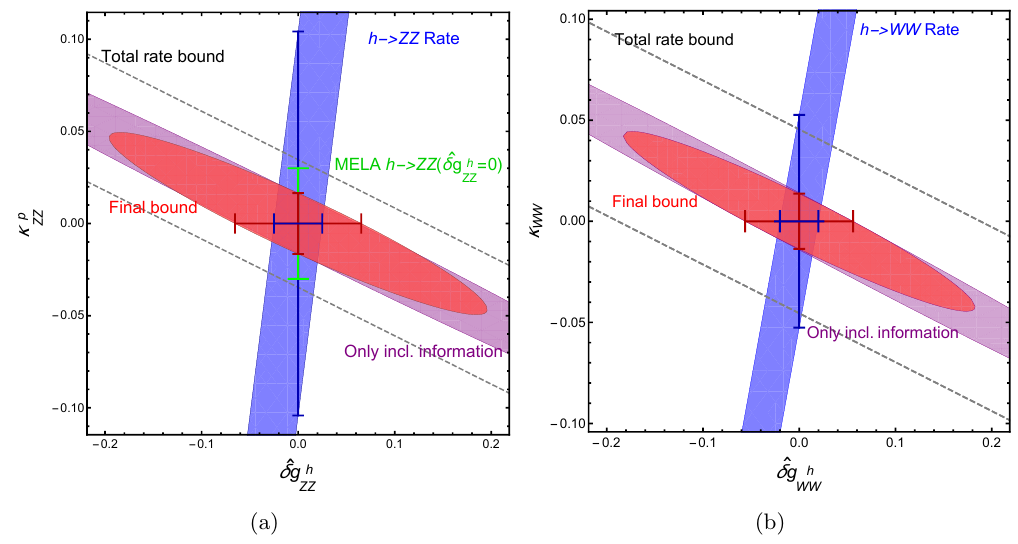
Figure 4 . (a) Bounds at 65% CL on the CP -even anomalous couplings from Zh production with 3 ab (cid:0) 1 integrated luminosity, assuming that the contact term has been very precisely constrained (see eq. (6.2)). We show the improvement of the bounds as more and more di(cid:11)erential information is included in the (cid:12)t. The dashed lines show the bound just from the total rate. The purple region includes di(cid:11)erential information at the level of the Z -boson four momentum such as the (cid:12)nal state invariant mass distribution and (cid:2)-distribution. Finally the red region includes information from all the angular moments including the cross-helicity interference terms. The blue band shows the bound from h ! ZZ ! 4 ‘ rate using the results of ref. [105]. The bars show the bounds on one of the couplings when the other coupling is 0. The green bar shows the bound obtained using the Matrix Element Likelihood Analysis (MELA) in ref. [79] and assuming (cid:14) ^ g h = 0. (b) Same as in ZZ (a) but for the W (cid:6) h mode where there is no bound from